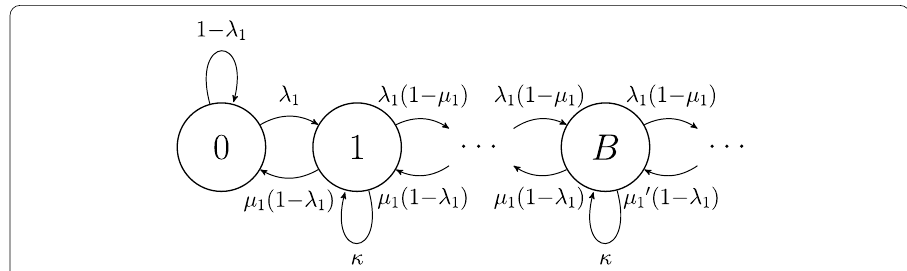
Fig. 2 The Discrete Time Markov Chain (DTMC) that models the evolution of Q 1 . The service probabilities µ 1 and µ ′ 1 are given by (2) and (8),